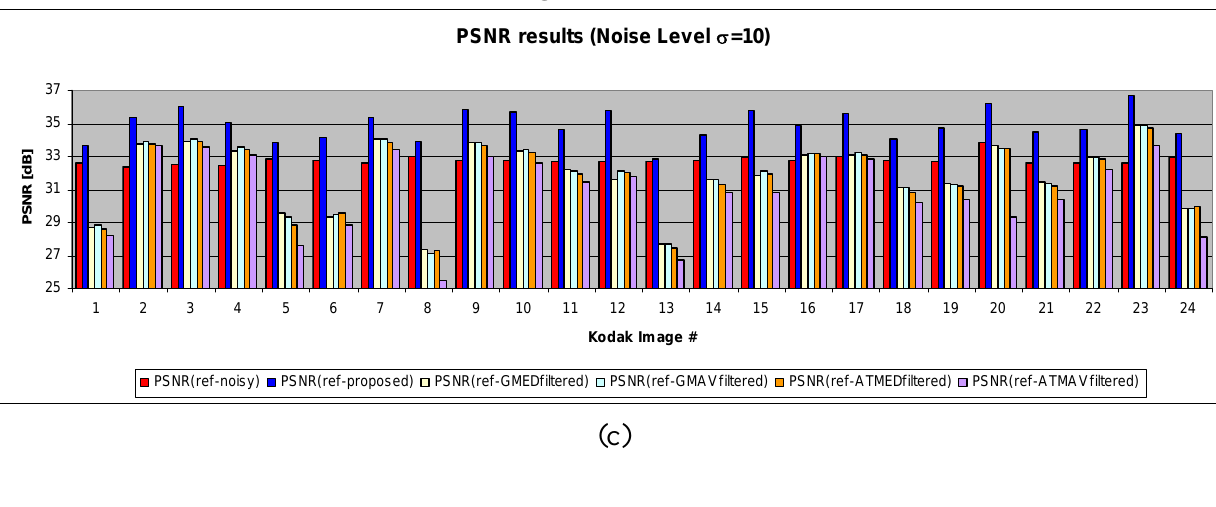
Figure 21. Cont. PSNR results (Noise Level 